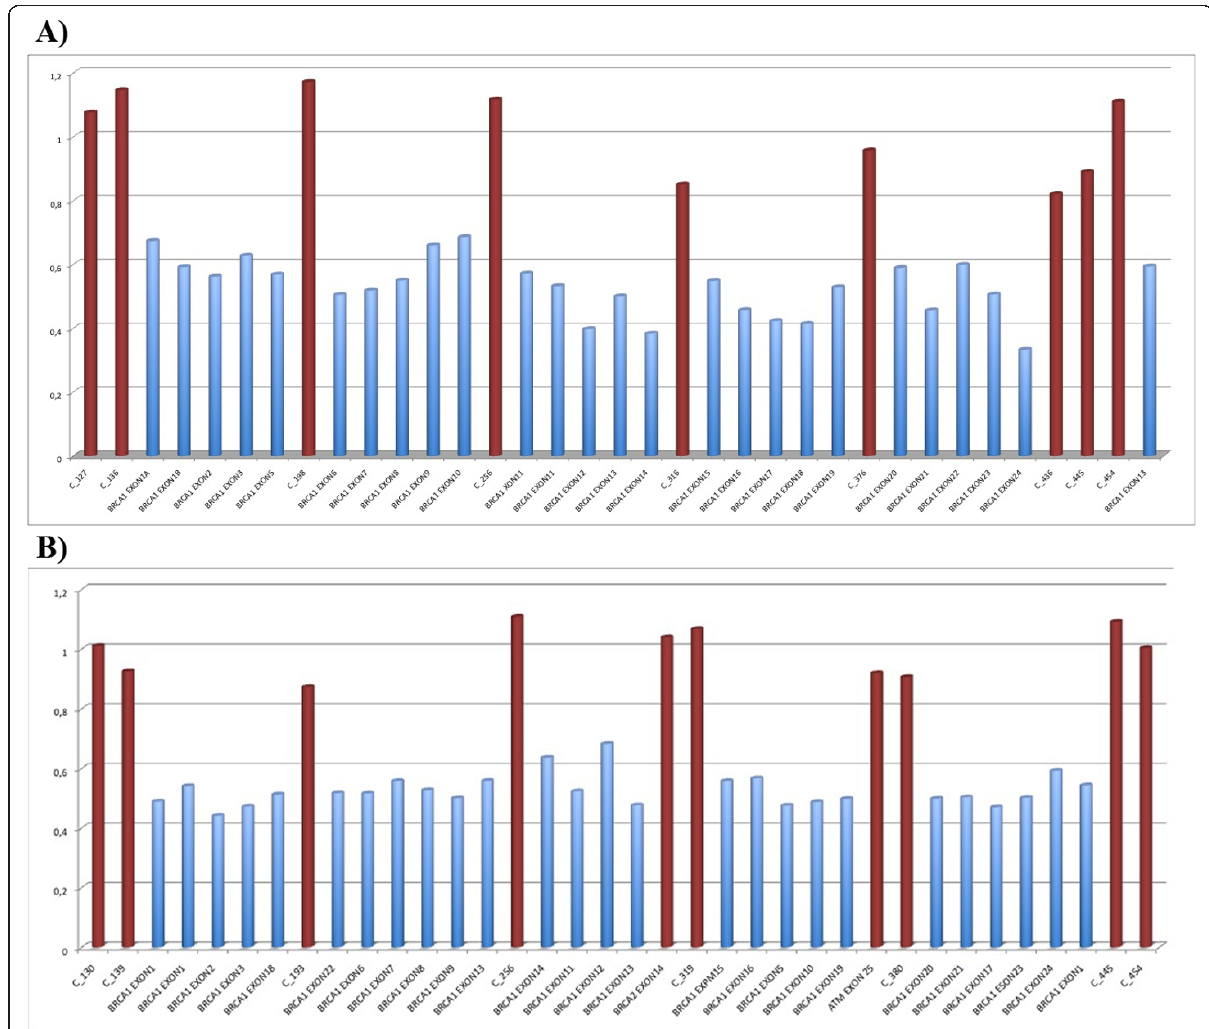
Figure 2 MLPA analysis of the BRCA1 gene performed with the SALSA MLPA KIT P002 (panel A) and P087 (panel B) (MRC-Holland) . Graph displaying the ratios between the relative peak areas for proband and controls. Grey and black bars correspond to BRCA1 and control probes respectively. The analysis revealed a 50% decreased amplification of the probes corresponding to BRCA1